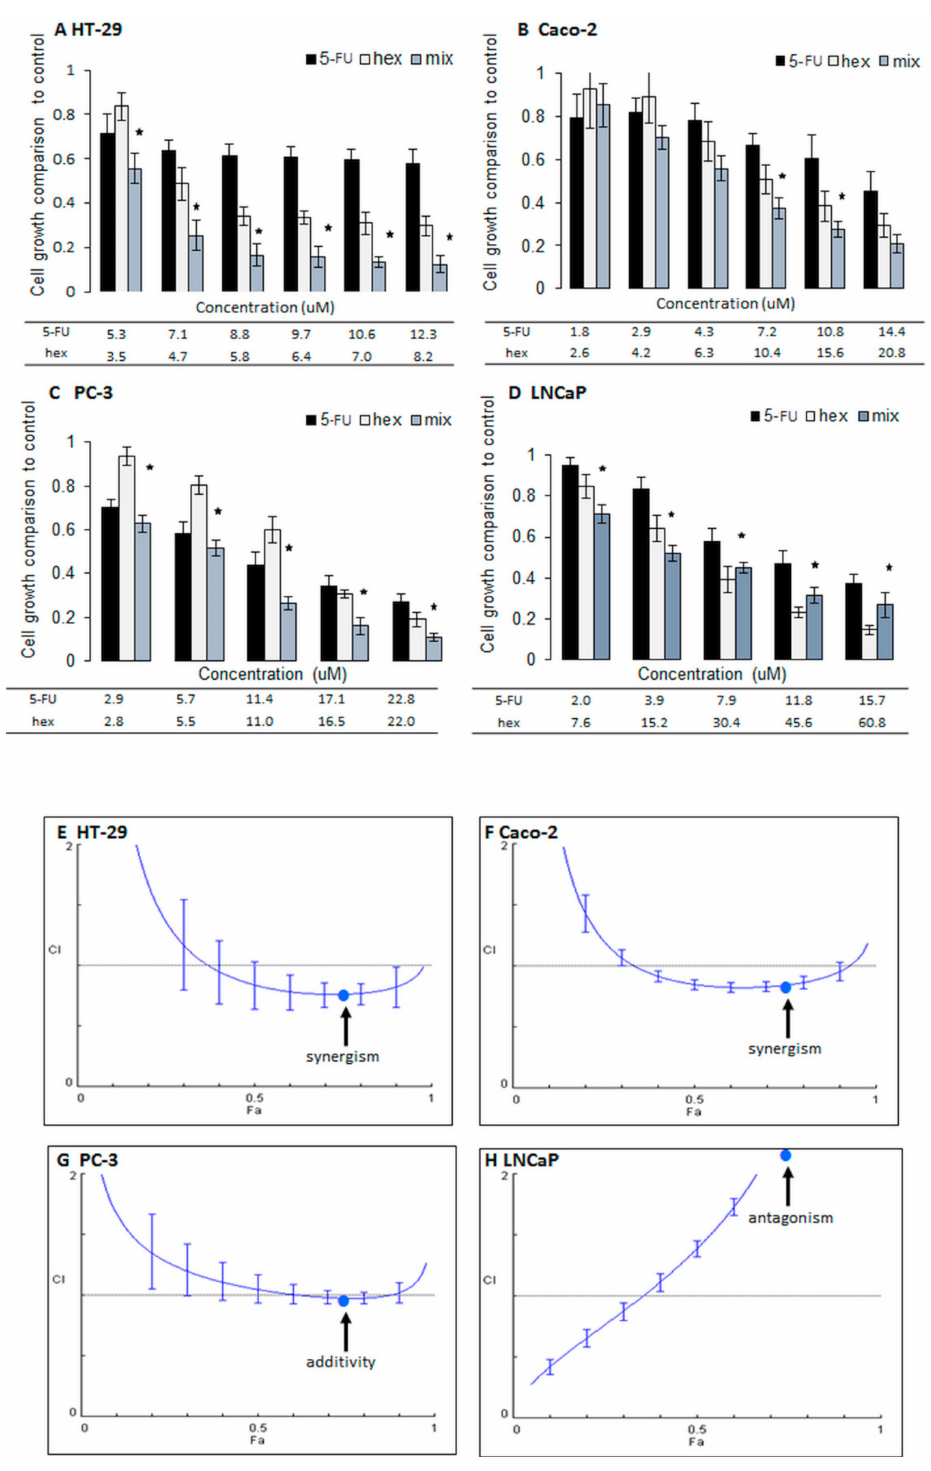
Figure 2. Cell growth inhibition and interaction types. The changes in cell growth of cancer cell lines after the administration of compounds alone and in combination: 5-fluorouracil (5-FU) with 2-oxohexyl ITC (hex) in HT-29 ( A ), Caco-2 ( B ), PC-3 ( C ), and LNCaP ( D ) cell lines. * The cell growth values after the administration of a combination treatment were statistically significantly